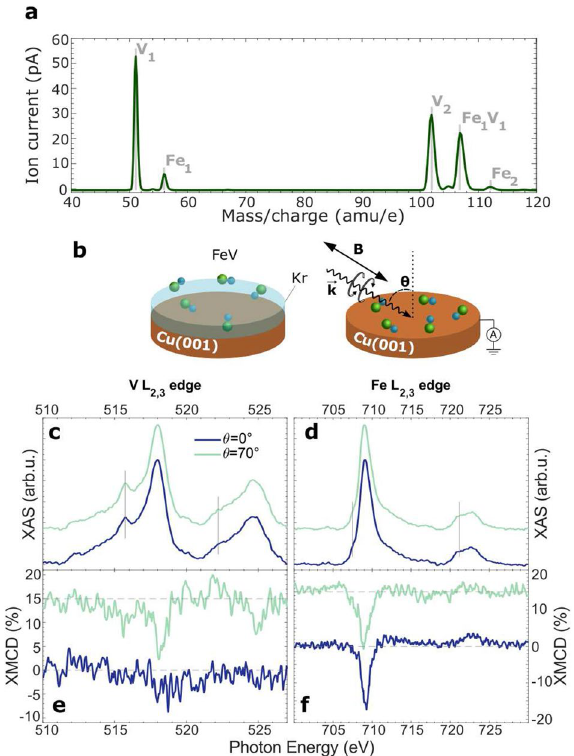
Figure 1. ( a ) Mass-to-charge spectrum of cluster ions up to n=2, produced from the FeV target. ( b ) Left: sketch of the soft landing procedure. Right: schematic view of the measurement geometry after the Kr buffer is removed by flash heating to 120 K. The angle θ between the surface normal and the incoming photon beam is ◦ ◦ varied between 0 and 70 . The magnetic field strength B was alternated between − 7 and + 7 T. Background ◦ ◦ corrected white line spectra taken at θ =0 and θ =70 for V 1 /Cu(001) ( c ) and Fe 1 /Cu(001) ( d ). ( e ) and ( f ) are the XMCD spectra corresponding to ( c ) and ( d ). All spectra are normalized to the L 3 peak value of the corresponding white line spectrum and vertically offset for better visibility.